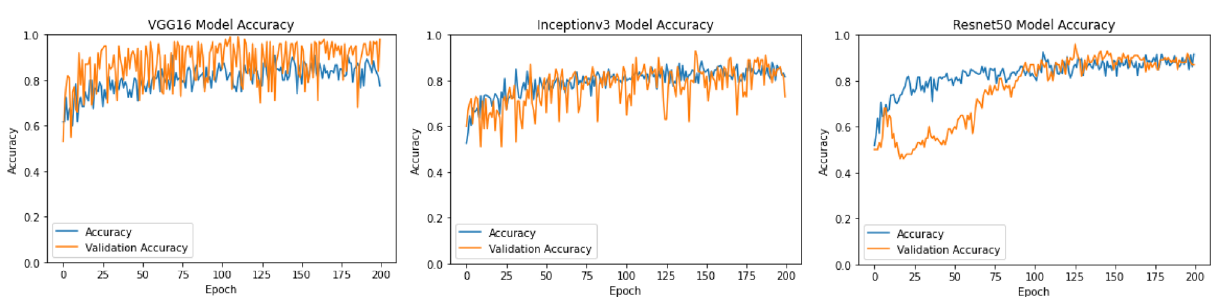
Figure 8. Performance evaluation of deep learning classifier on Hust19 Data-set.